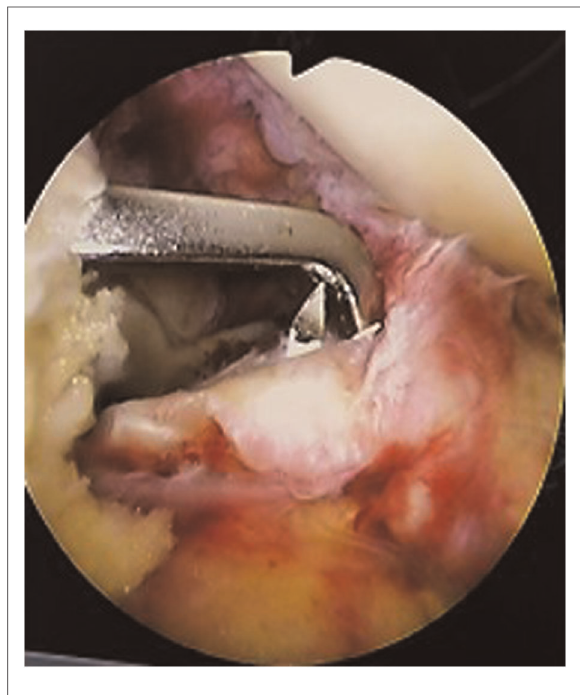
FIGURE 3 Arthroscopic view: the guide hole the reduction and determines the pain placement, insert the guide needle into the guide to set the